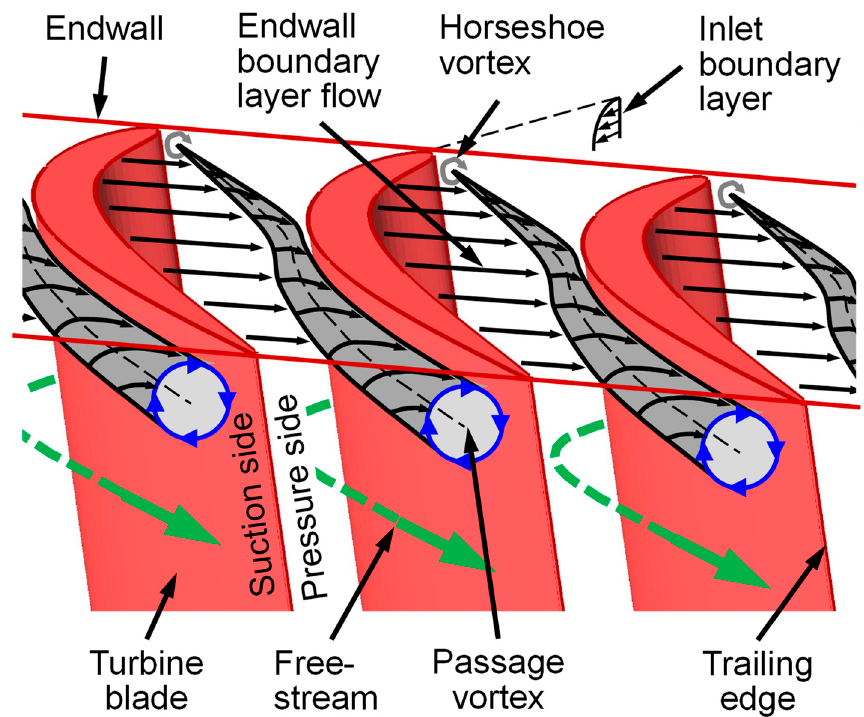
Figure 1. Passage vortex generated in turbine blades.